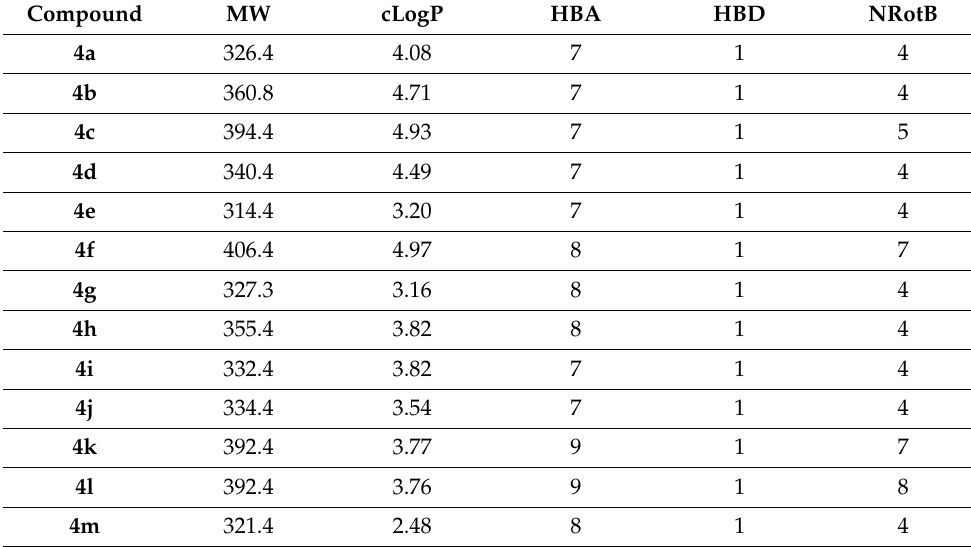
Table 4. Molecular parameters of compounds 4a–m defining drug-likeness according to Lipinski [44] [MW—molecular weight (<500), cLogP—calculated lipophilicity characteristic defined as 1- octanol/water partitioning coefficient (<5.0), HBA—number of hydrogen bond acceptors